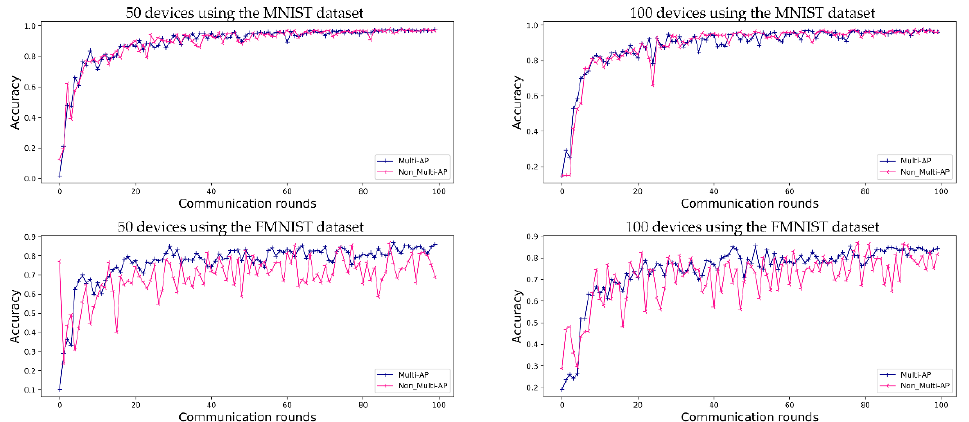
Figure 4. Evaluation of FL prediction accuracy using the MNIST and FMNIST datasets in an environment with five APs during 100 communication rounds. ‘Multi-AP’ shows the results for the proposed method, and ‘Non_Multi - AP’ shows those of a comparative method without multi -AP coordination.